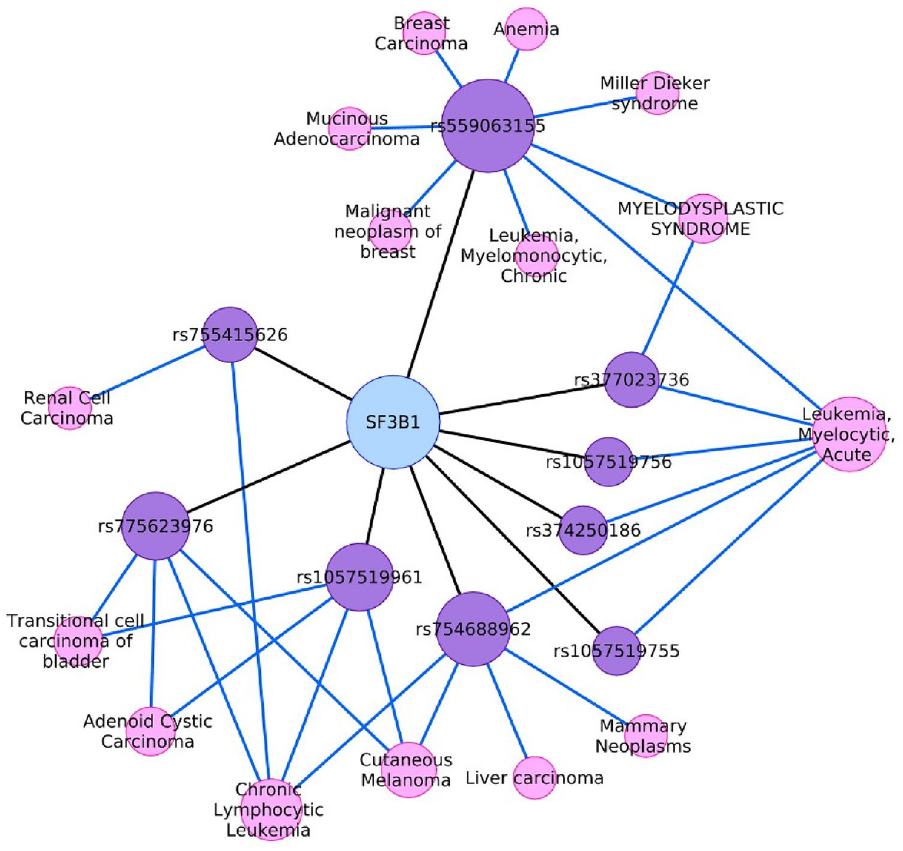
Figure 5. The constructed variant-disease network shows one cyan node which represents SF3B1 gene. It is connected to 9 purple nodes representing variants and each of them is connected to one or more pink nodes representing disease. Overall, the network has 25 nodes and 37 edges. Edges are colored in black or blue representing gene-variant or variant-disease associations, respectively.